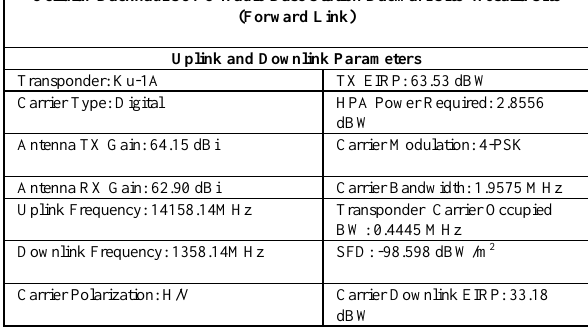
Table 6. Cellular Backhaul SCPC link budget (forward link)